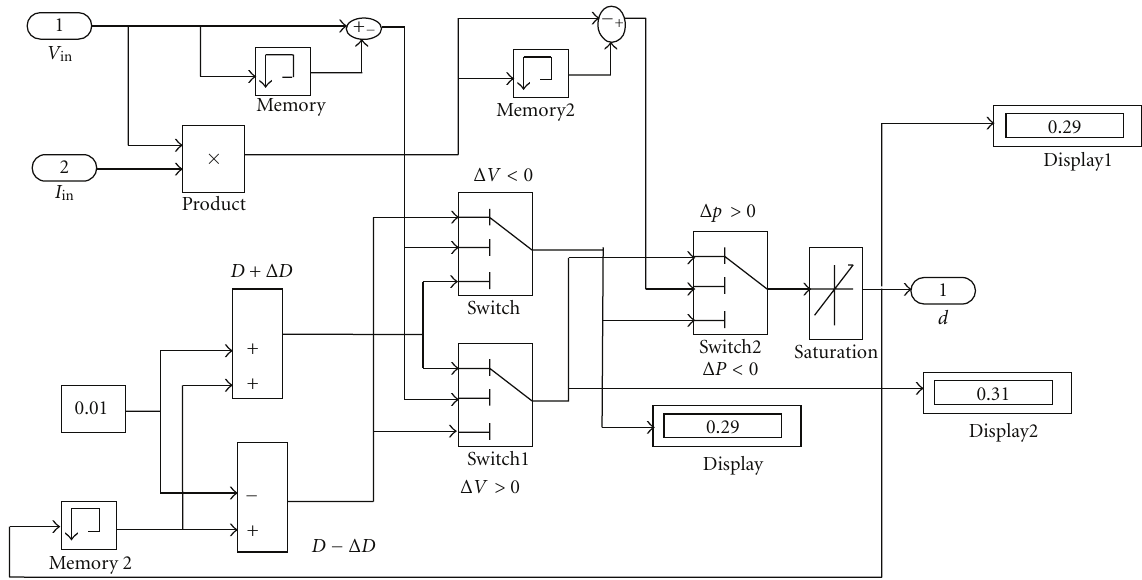
Figure 21: Simulink model for P&O MPPT